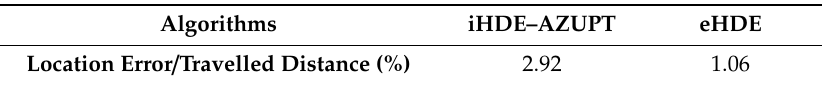
Table 5. Location Table 5. Location error.